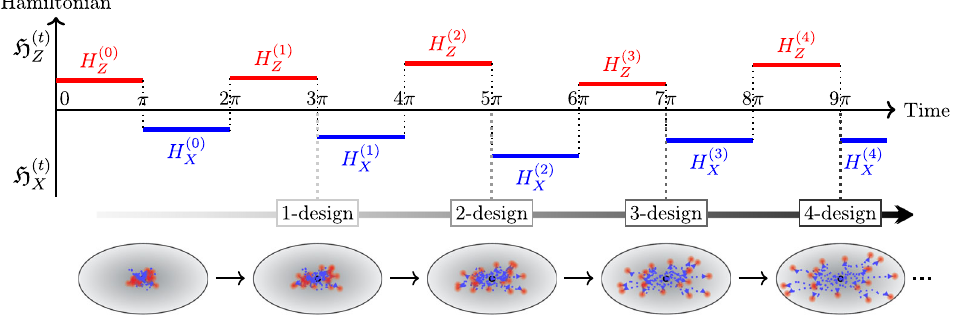
∈ H ð t Þ . At each time interval m , H ð m Þ XZ R XZ